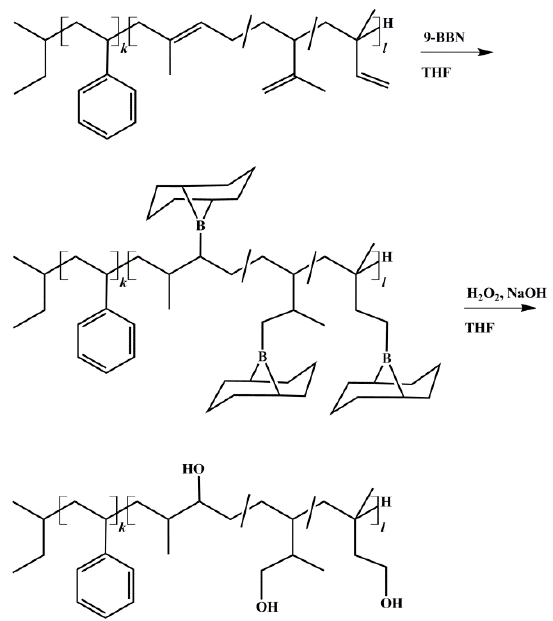
Figure 3. Reaction scheme for hydroxylation of block copolymers with 9 ‐ BBN (9 ‐ borabicyclo[3.3.1]nonane), shown for polystyrene ‐ block ‐ polyisoprene (SI) diblock copolymer. Anti ‐ Markovnikov product is obtained due to large steric requirements of the alkyl borane during addition [40].